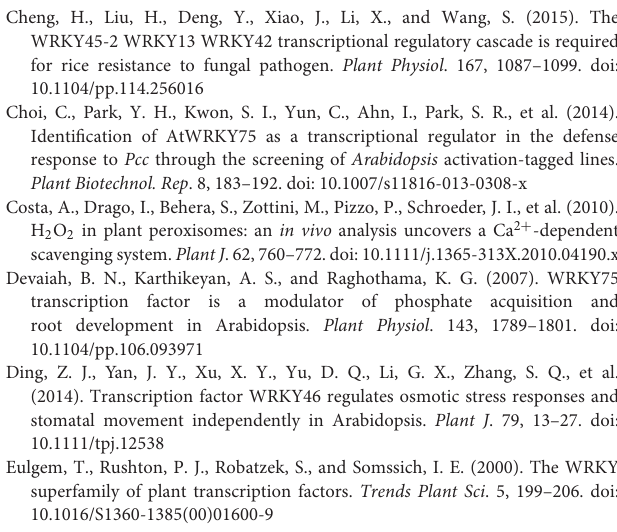
Table S6 | The expression data (log2-based values) of the cassava WRKY genes after various stresses, ABA and H 2 O 2 treatments. Table S7 | The accession number of transcriptomic data in